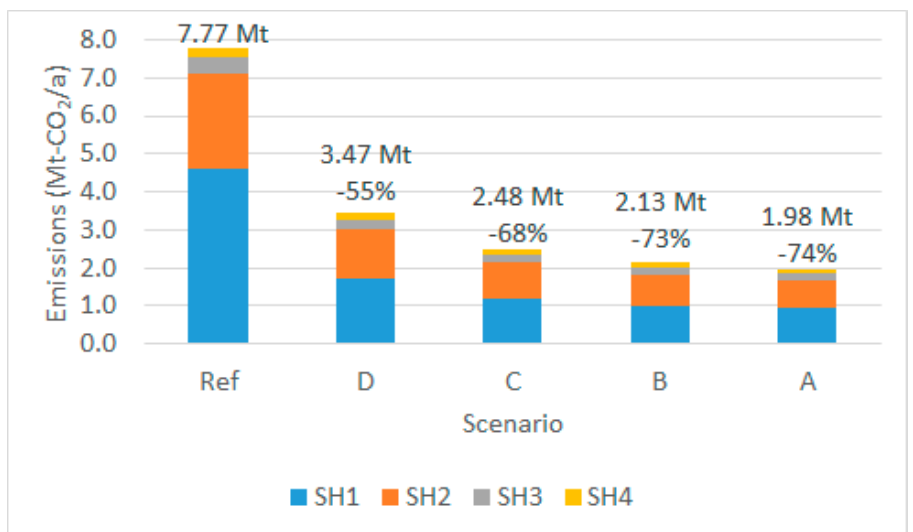
Figure 12. Assumed distribution of heating systems in the optimized scenarios.